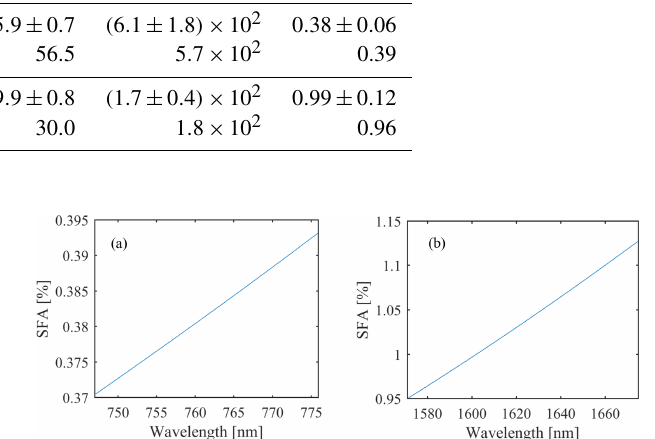
Figure 5. Scaling of the SFA with the wavelength of a CO2I-like instrument in the (a) NIR and (b) SWIR band, using the prediction